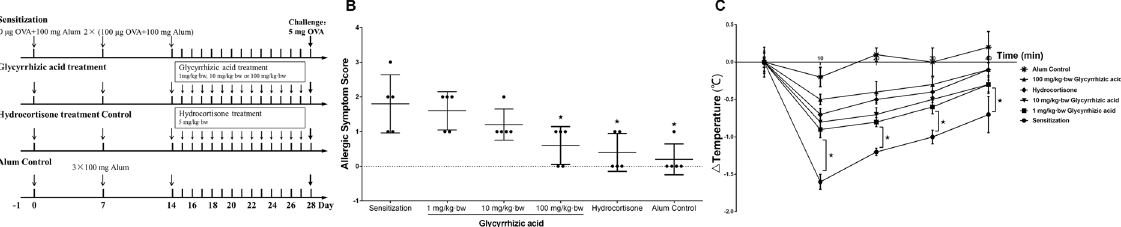
Figure 1. GA attenuated clinical allergic symptoms and the variation of rectal temperature in Balb/c mice. * P < 0.05 as compared to the sensitization group (n = 5). ( A ) Schematic drawing representing the Balb/c mice active system food anaphylaxis protocols and doses used in this work. ( B ) Allergic symptom score and ( C ) The variation of rectal temperature (°C).